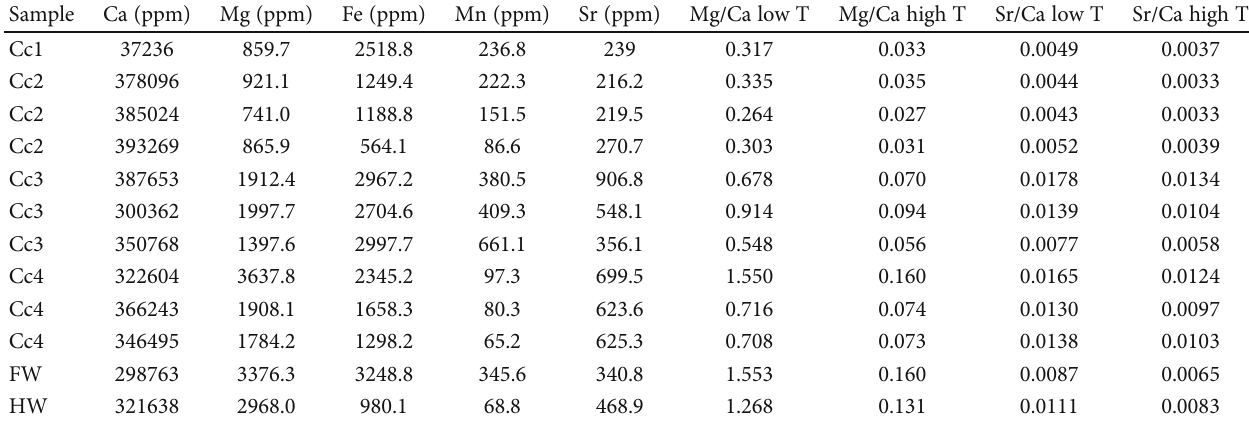
Table 2: Elemental composition (Ca, Mg, Fe, Mn, and Sr) of the di ff erent calcite cements (Cc1 to Cc4), the interparticle cement Cc0 in the footwall host rocks (FW), and the hanging wall rocks (HW). The calculated Mg/Ca and Sr/Ca molar ratios of the parent fl uid using the distribution coe ffi cient equation [57] are also shown.